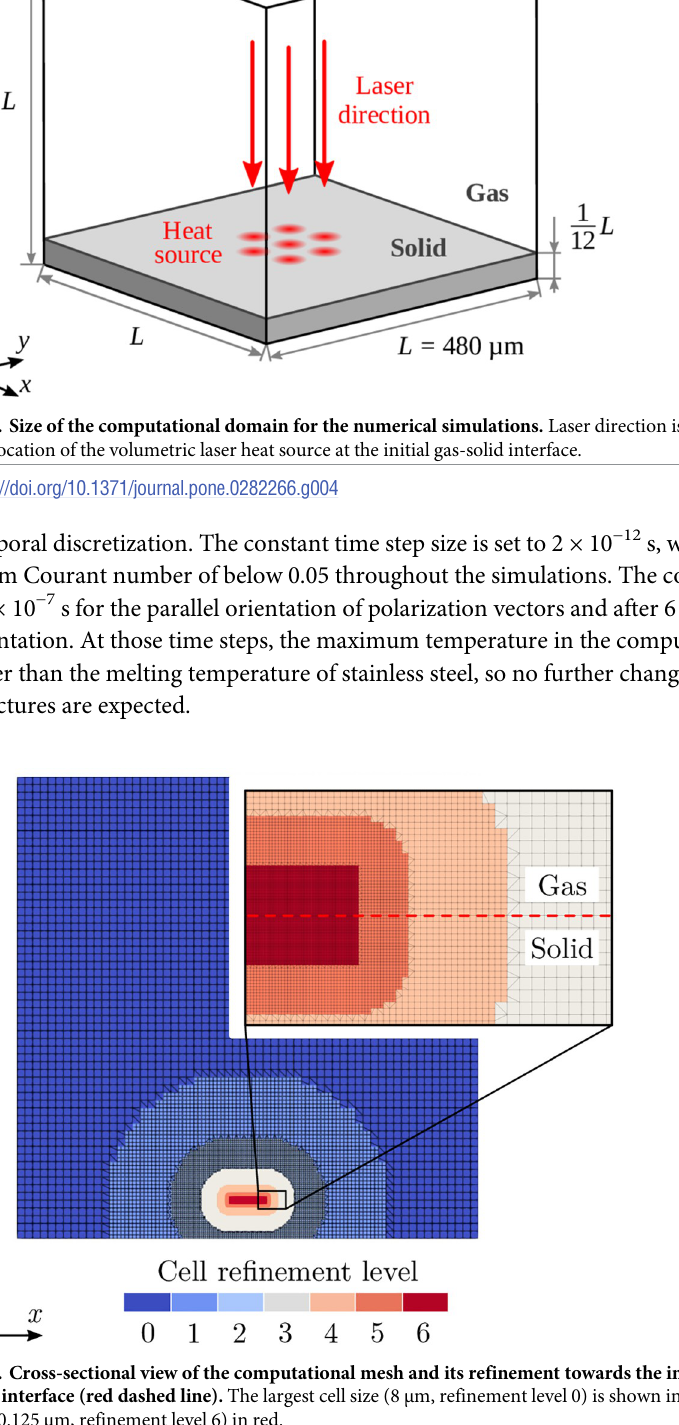
Fig 5. Cross-sectional view of the computational mesh and its refinement towards the initial location of the gas- solid interface (red dashed line). The largest cell size (8 µ m, refinement level 0) is shown in dark blue, the smallest cell size (0.125 µ m, refinement level 6) in